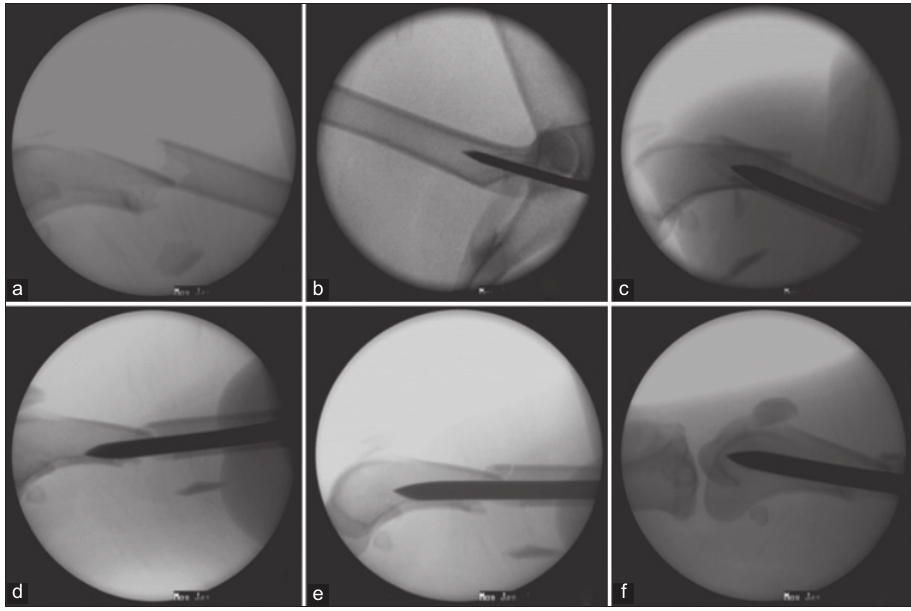
Figure-4: C-arm guided simple intramedullary pinning in femur. (a) Fracture site of femur, (b) Insertion of pin into the proximal end of femur, (c) Pin at the fracture site of femur, (d) Toggling of the fractured bone fragments to reduce the fracture, (e) Advancing the pin into the distal fragment of femur, (f) Seating the pin into the distal